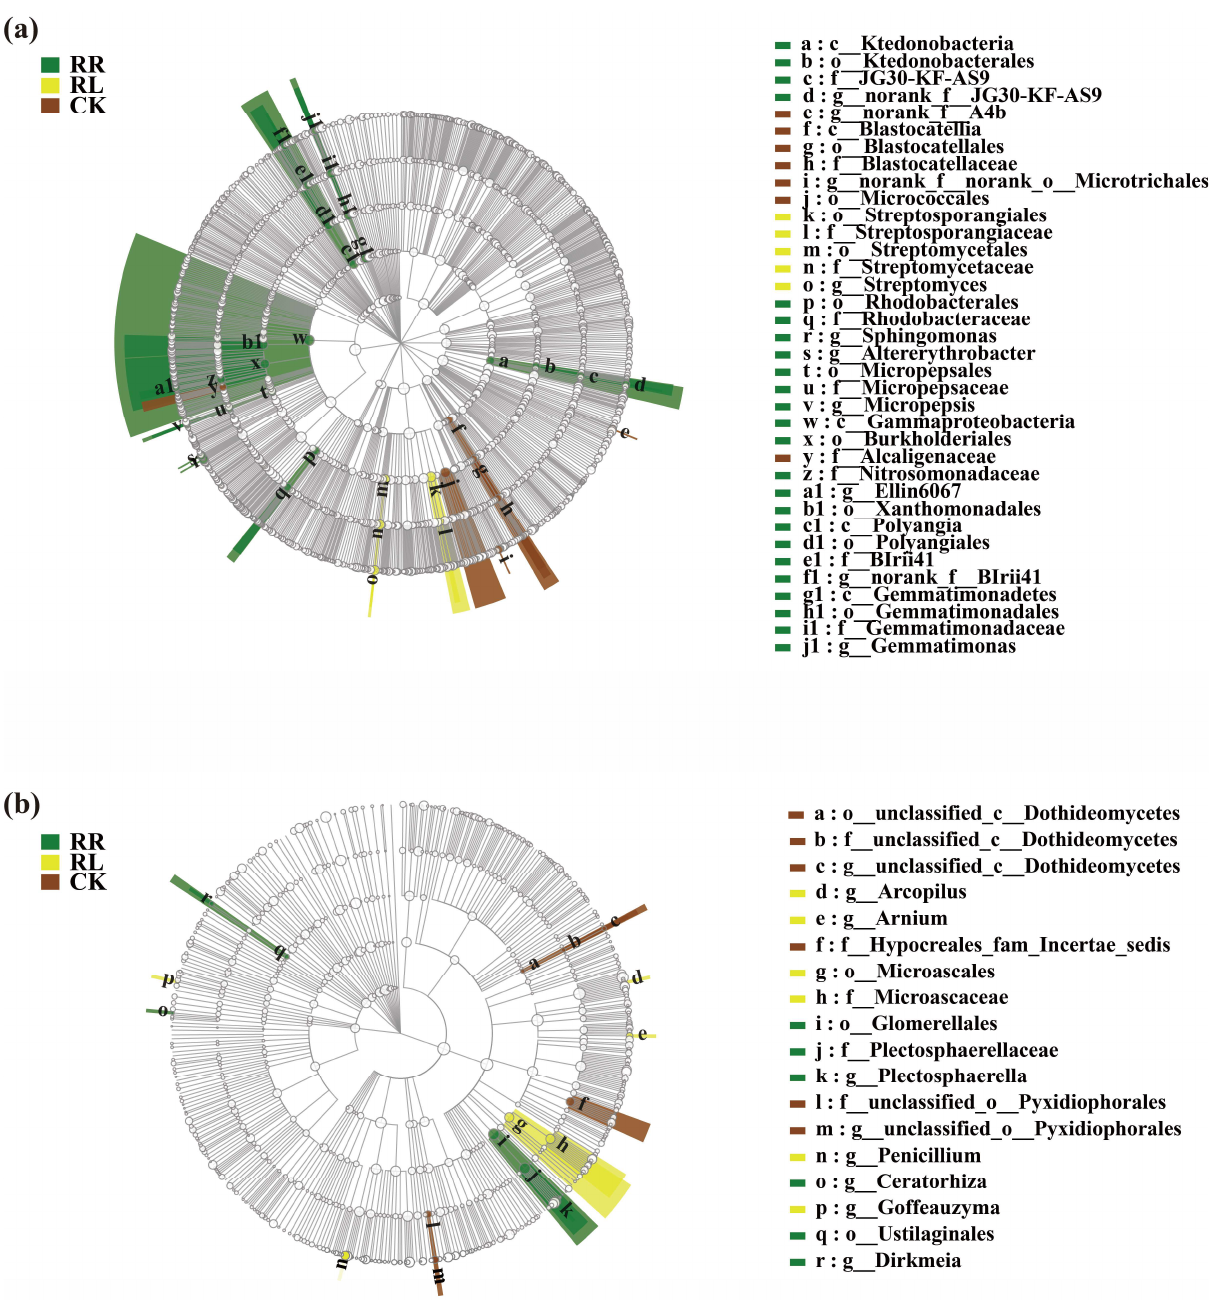
Figure 6. LEfSe analysis of soil bacteria ( a ) and fungi ( b ) in the rhizosphere of crops under the monoculture (RR) and intercropping system (RL) and CK. Different color regions represent different constituents (green: RR; yellow, RL; brown: CK). Circles indicate the phylogenetic level from the phylum to the genus. The diameter of each circle is proportional to the abundance of the group. Different prefixes indicate different levels (p: phylum; c: class, o: order; f: family; g: genus).